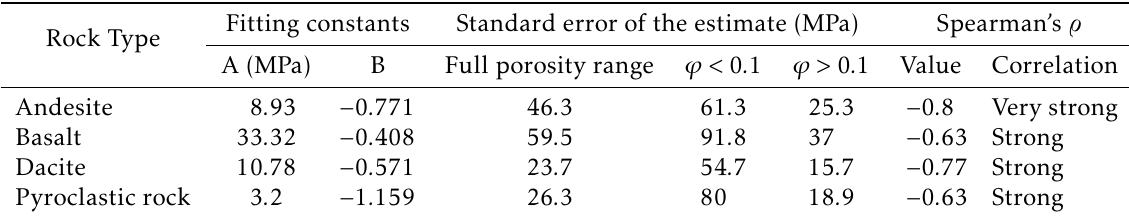
Table 3: Empirical fitting constants, SEE, and Spearman’s (cid:37) for Equation 14 for the volcanic rock datasets in Fig- ure 3. Note that porosity must be given as a fraction in Equation 9, not as a percentage for the fitting parameters to be